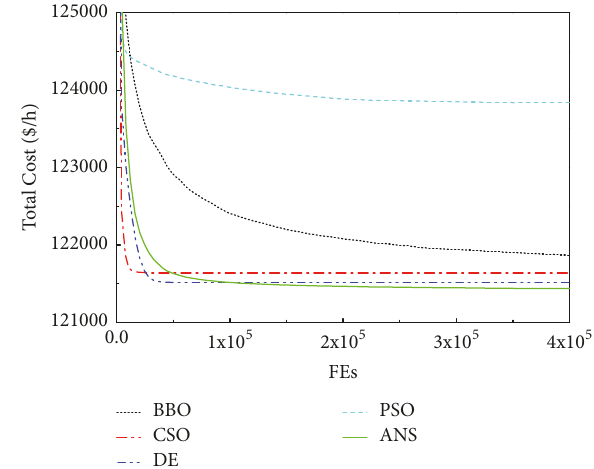
Figure 5: Convergence curves for the 40-generator system